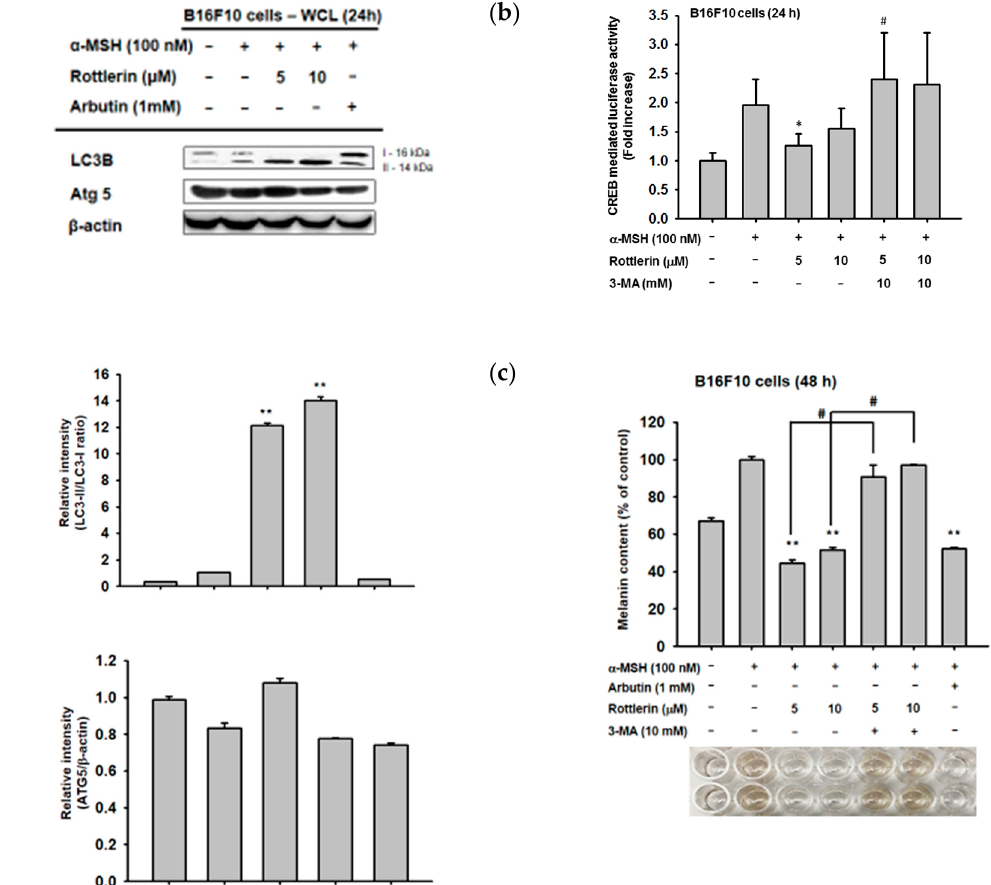
Figure 5. Rottlerin downregulates CREB-mediated melanogenesis by the activity of autophagy. ( a ) Confirmation of rottlerin as an autophagy inducer was achieved by assessing levels of autophagy-related proteins, such as LC3 and ATG5, by immunoblotting analysis under the same conditions for 24 h. ( b ) B16-F10 cells (10 5 cells / mL) were transfected with CREB-Luc and β -gal (0.8 µ g) for 24 h, activated with α -MSH 24 h after CREB-Luc transfection, and ( c ) treated with α -MSH with or without 5 and 10 µ M of rottlerin and 3-MA (10 mM). Luciferase activity was measured with a luminometer. ( c ) B16-F10 cells (10 5 cells / mL) were induced by α -MSH in the presence or absence of rottlerin (5 and 10 µ M) or arbutin (1 mM) as well as 3-MA (10 mM) for 48 h, and level of intracellular melanin content was measured by spectrophotometry. All data ( b , c ) are expressed as the mean ± SD of three replicates. * p < 0.05 and ** p < 0.01 compared to control groups. # p < 0.01 compared to selected groups.